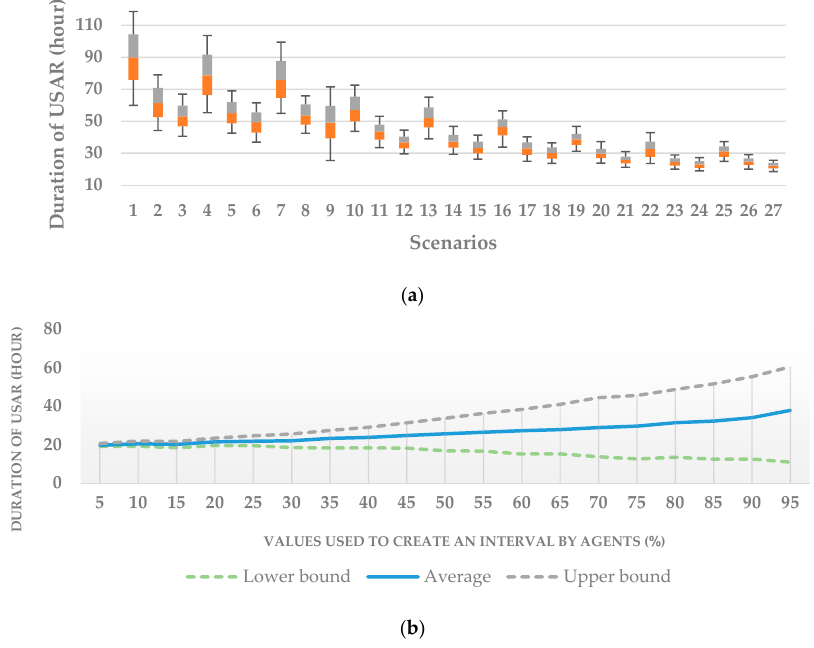
Figure 7. Uncertainty analysis of the proposed method in USAR operations, ( a ) for 27 simulated scenarios, ( b ) for different values in determining intervals on the 27th scenario.